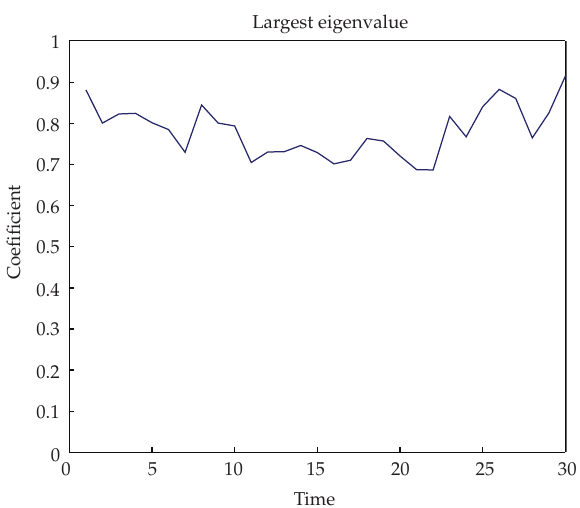
Figure 4: The correlation coe ffi cient of the aggregate flow vector and the corresponding